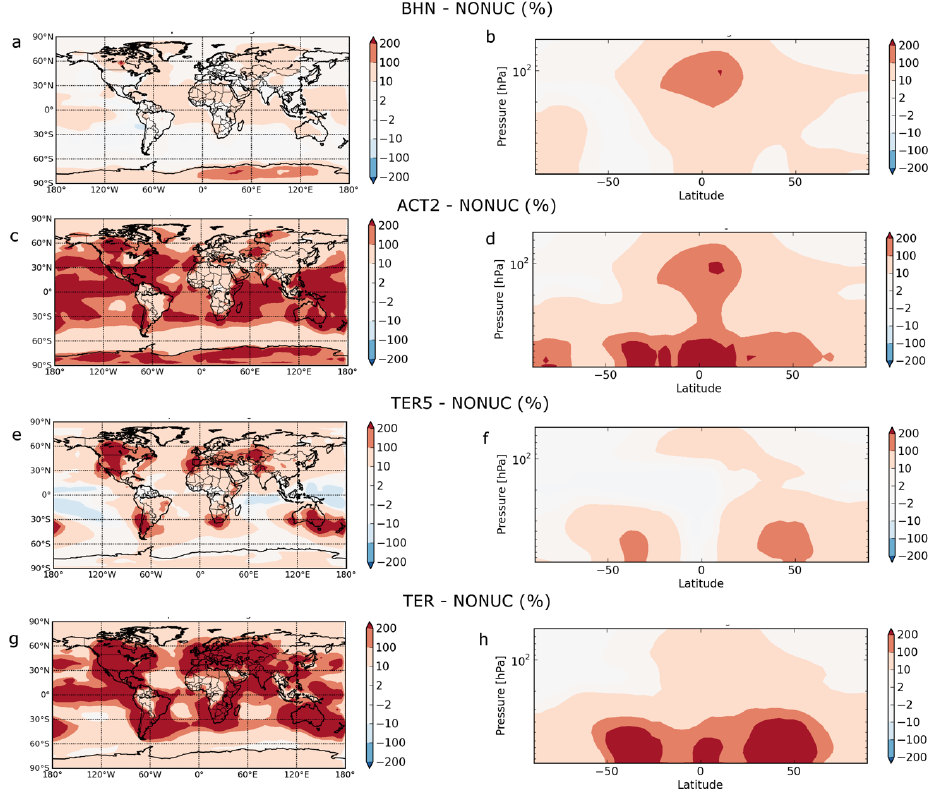
Figure 2. Global percent change in total particle number concentration ( N 10 ) surface and zonal plots. Color contours in all panels represent the percent change in number concentration between the listed nucleation simulations and the simulation with nucleation off: (a, b) binary; (c, d) Activation ( A = 2 × 10 − 6 ); (e, f) Ternary (10 − 5 factor); (g, h) Ternary.